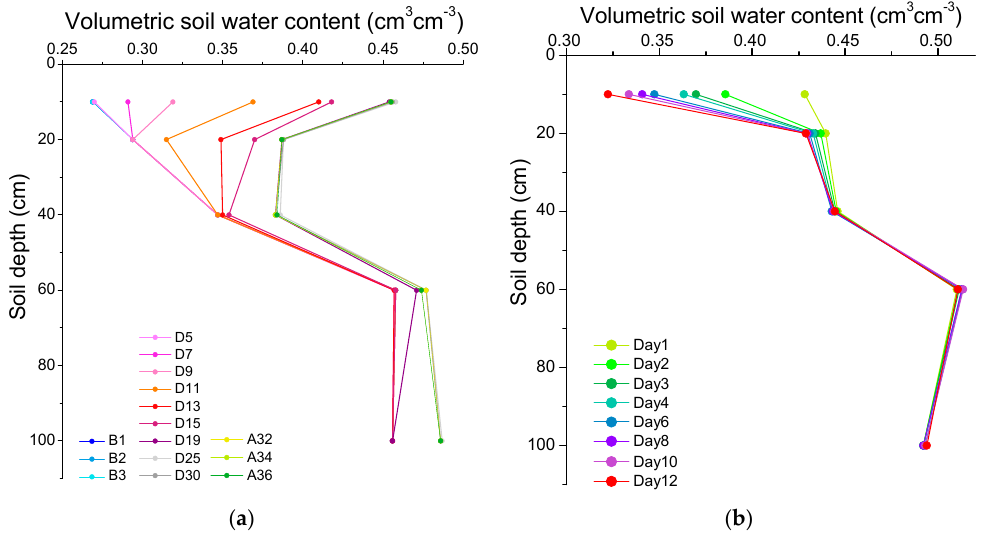
Figure 4. Soil water content at different depths of a soil profile: ( a ) during a rainfall event; and ( b ) during the 12-day evaporation period. Lines B1 to B3, D5 to D30 and A32 to A36 represent the soil water content before, during and after a rainfall event, respectively; the numbers represent the number of hours. Lines Day1 to Day12 show the soil water content from the first day to the twelfth day and the numbers represent the number of days.